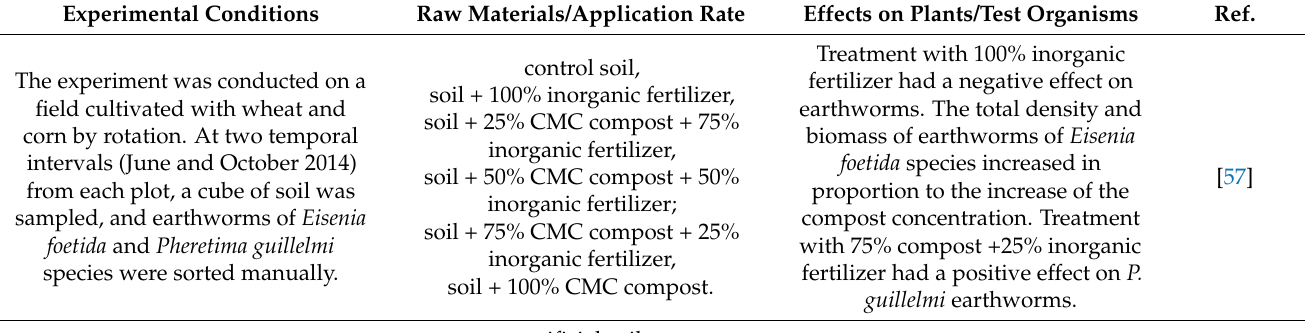
Table 3. Experiments using sewage sludge biochar/sewage